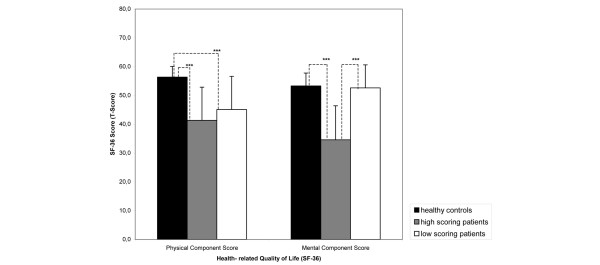
Difference in mental and physical component summary between groups. The mental and physical component summary of health-related quality of life was measured with the Medical Outcomes Study 36-Item Short Form (SF-36), comparing between 'high-scoring patients' with a Post-Traumatic Stress Syndrome 10-Questions Inventory (PTSS-10) score greater than or equal to the cutoff score of 35 points, indicating an increased risk for development of post-traumatic stress disorder, and 'low-scoring patients' with a PTSS-10 below the cutoff score, and age- and gender-matched healthy controls. Significant difference (***p < 0.0001)was calculated with analysis of variance and post-hoc t tests for independent samples. The broken line indicates a significant difference between groups as determined with the t test.